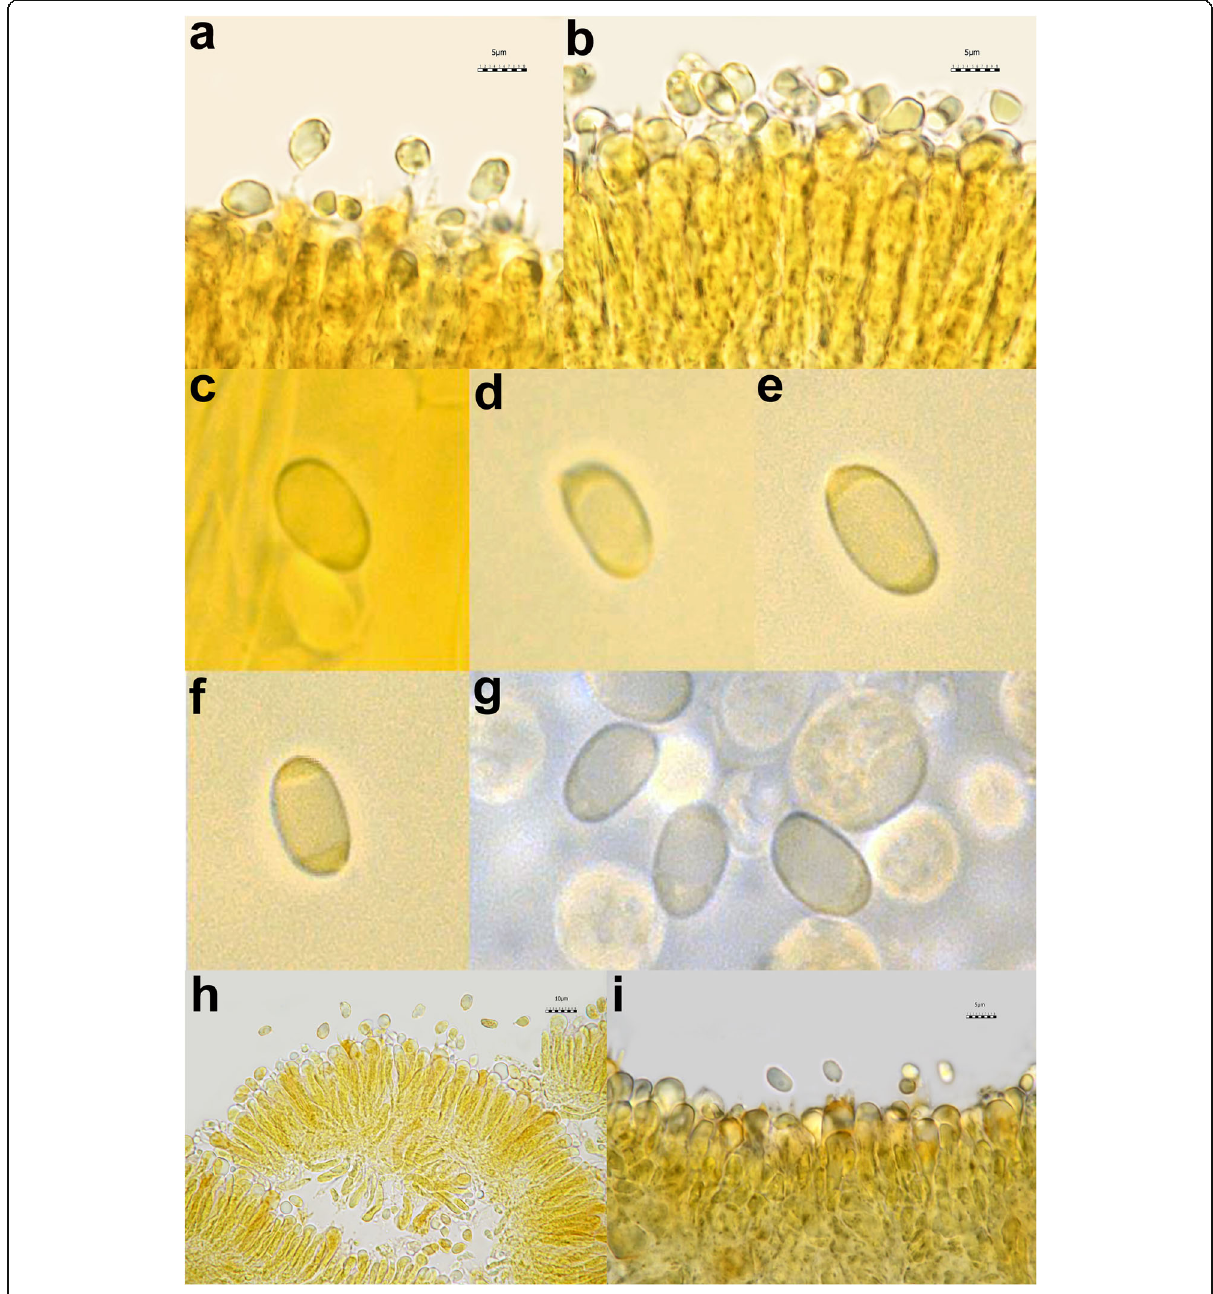
Fig. 4 Spores and basidia of Tricholoma argyraceum (AMB 17211) observed in Melzer ’ s without pre-heating. a – b Sample soaked in 5% ammonia and observed in Melzer ’ s immediately after squashing. c – g Sample soaked in 5% ammonia and observed after leaving the sample in Melzer ’ s for 30 min. h – i Sample soaked in tap water and observed leaving the sample in Melzer ’ s for 30 min. Photos a – b and h – i by L. Setti; c – g by H.